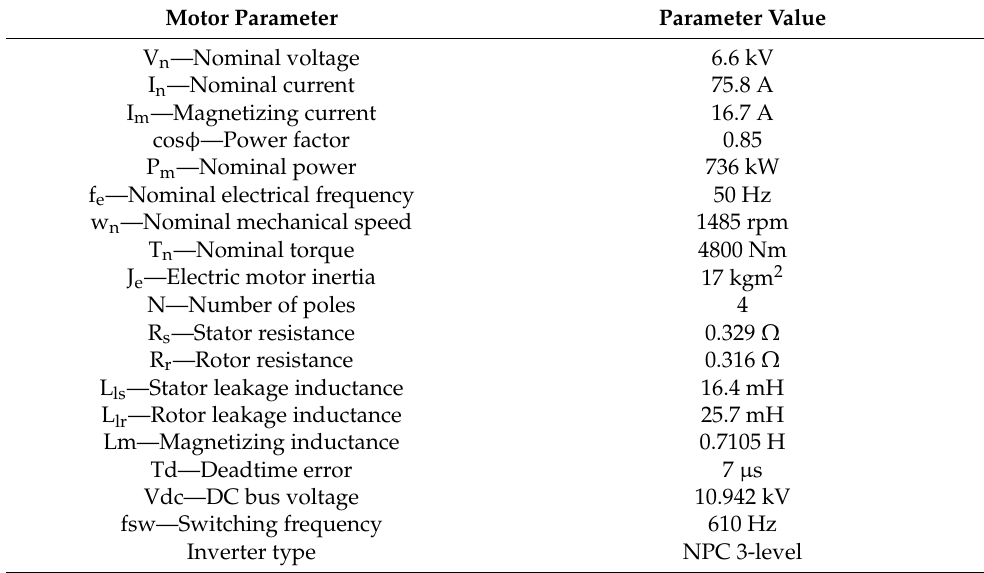
Table 1. Motor parameters.